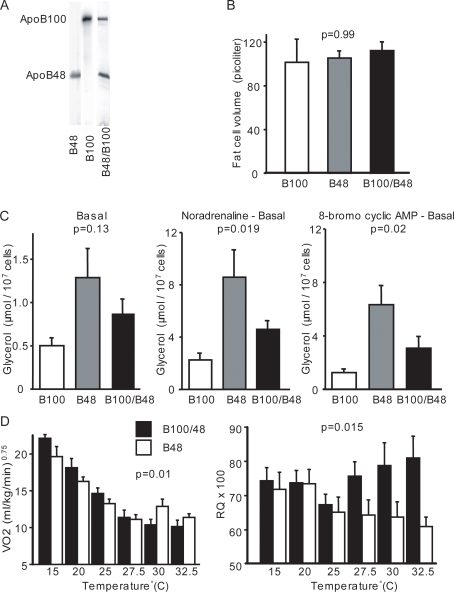
Effects of apoB100 in mice.Plasma and gonadal fat pads were isolated after an overnight fast from 10-week-old wild-type mice (B100/B48) and mice lacking apoB100 (B48) or expressing only apoB100 (B100). (A) Western blots of plasma performed with rabbit anti-mouse apoB antibodies. (B) Gonadal fat pad cell volume (n≥12 mice per group (B100/B48;B48; B100); p = 0.99; DF = 2,35; F-value = 0.015). (C) Basal (p = 0.13; DF = 2,39; F-value = 2.4), noradrenaline-stimulated (p = 0.019; DF = 2,36; F-value = 3.8), and 8-bromo cyclic AMP–stimulated lipolysis (p = 0.02; DF = 2,38; F-value = 3.8) (n≥12 mice per group). (D) Resting oxygen consumption (VO2) and respiratory quotient (RQ) in mice kept at different environmental temperatures (n = 7–8 mice mice per group; DF = 1,13) p = 0.01; F-value = 3.3 for VO2 and p = 0.015; F-value = 3.1 for RQ). Error bars in (B–D) indicate SD. p-values were determined by ANOVA.